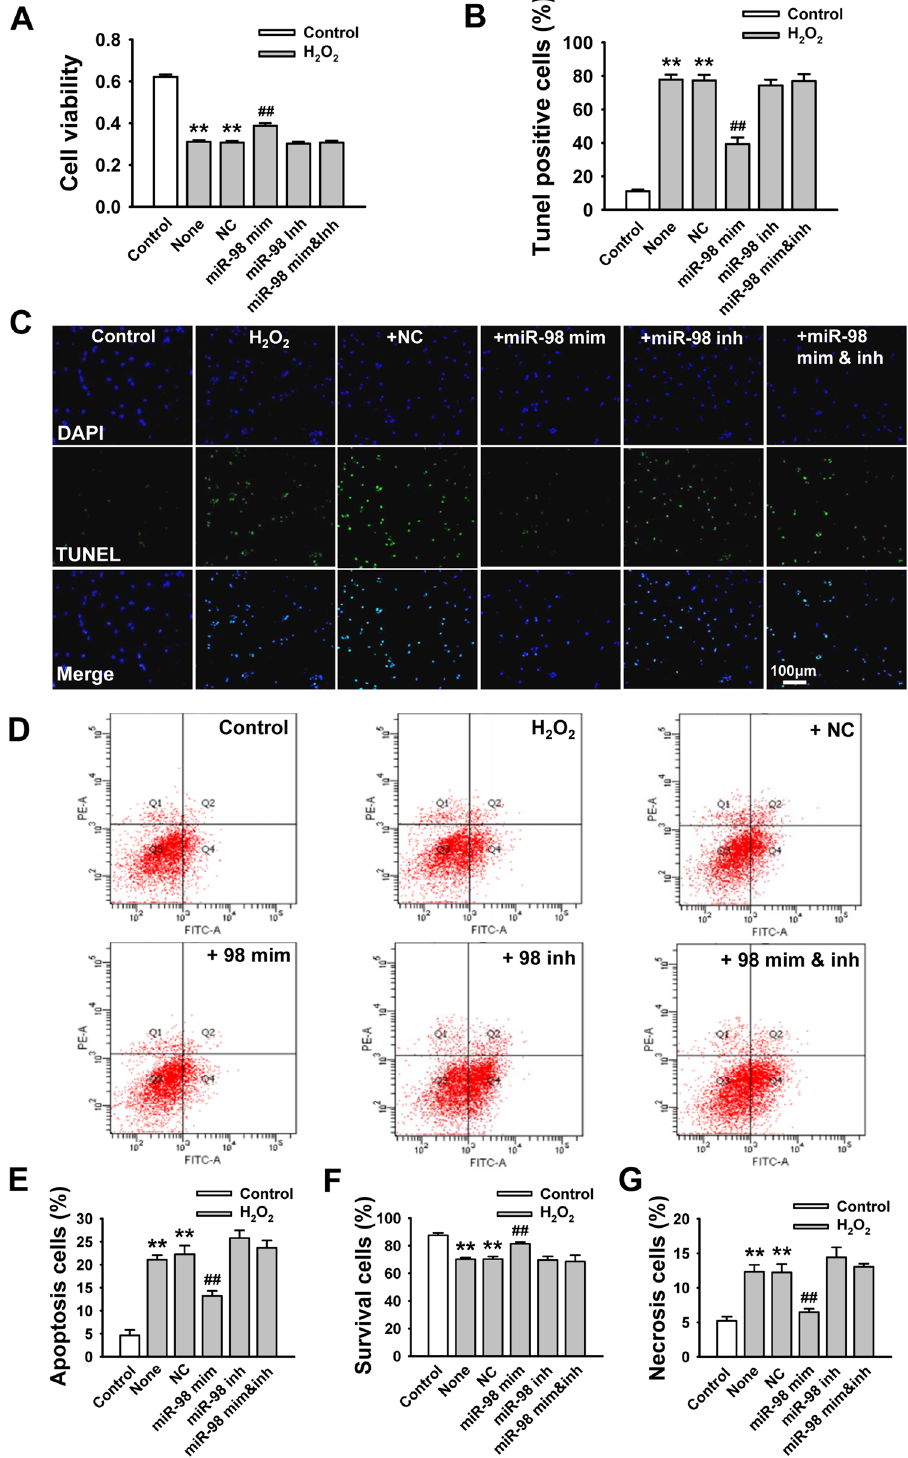
Figure 2. Overexpression of miR-98 prevents cardiomyocyte apoptosis in response to H 2 O 2 . NRVCs were transfected with NC (negative control), miR-98 mimic (miR-98 mim), miR-98 inhibitor (miR-98 inh), and miR- 98 mimic + inhibitor (miR-98 mim&inh) and then treated with H 2 O 2 (100 μ M) for 4 h. ( A ) MTT assay suggested that miR-98 mimic restored cell viability of NRVCs treated with 100 μ M H 2 O 2 for 4 h. n = 8. ( B ) Statistical results of TUNEL-positive cells per field indicated that miR-98 mimic suppressed H 2 O 2 treatment-induced cell apoptosis. n = 6. ( C ) Representative images of TUNEL staining of NRVCs for DNA defragmentation showing the apoptotic cells (nucleus stained in blue with DAPI and apoptotic cells stained in green). ( D ) The representative images of flow cytometry using Annexin V-FITC and PI staining. ( E )-( G ) Statistical analysis of apoptotic, survival and necrosis ratio of the flow cytometry data. n = 4; ** P < 0.01 versus control; ## P < 0.01 versus H 2 O 2 + NC